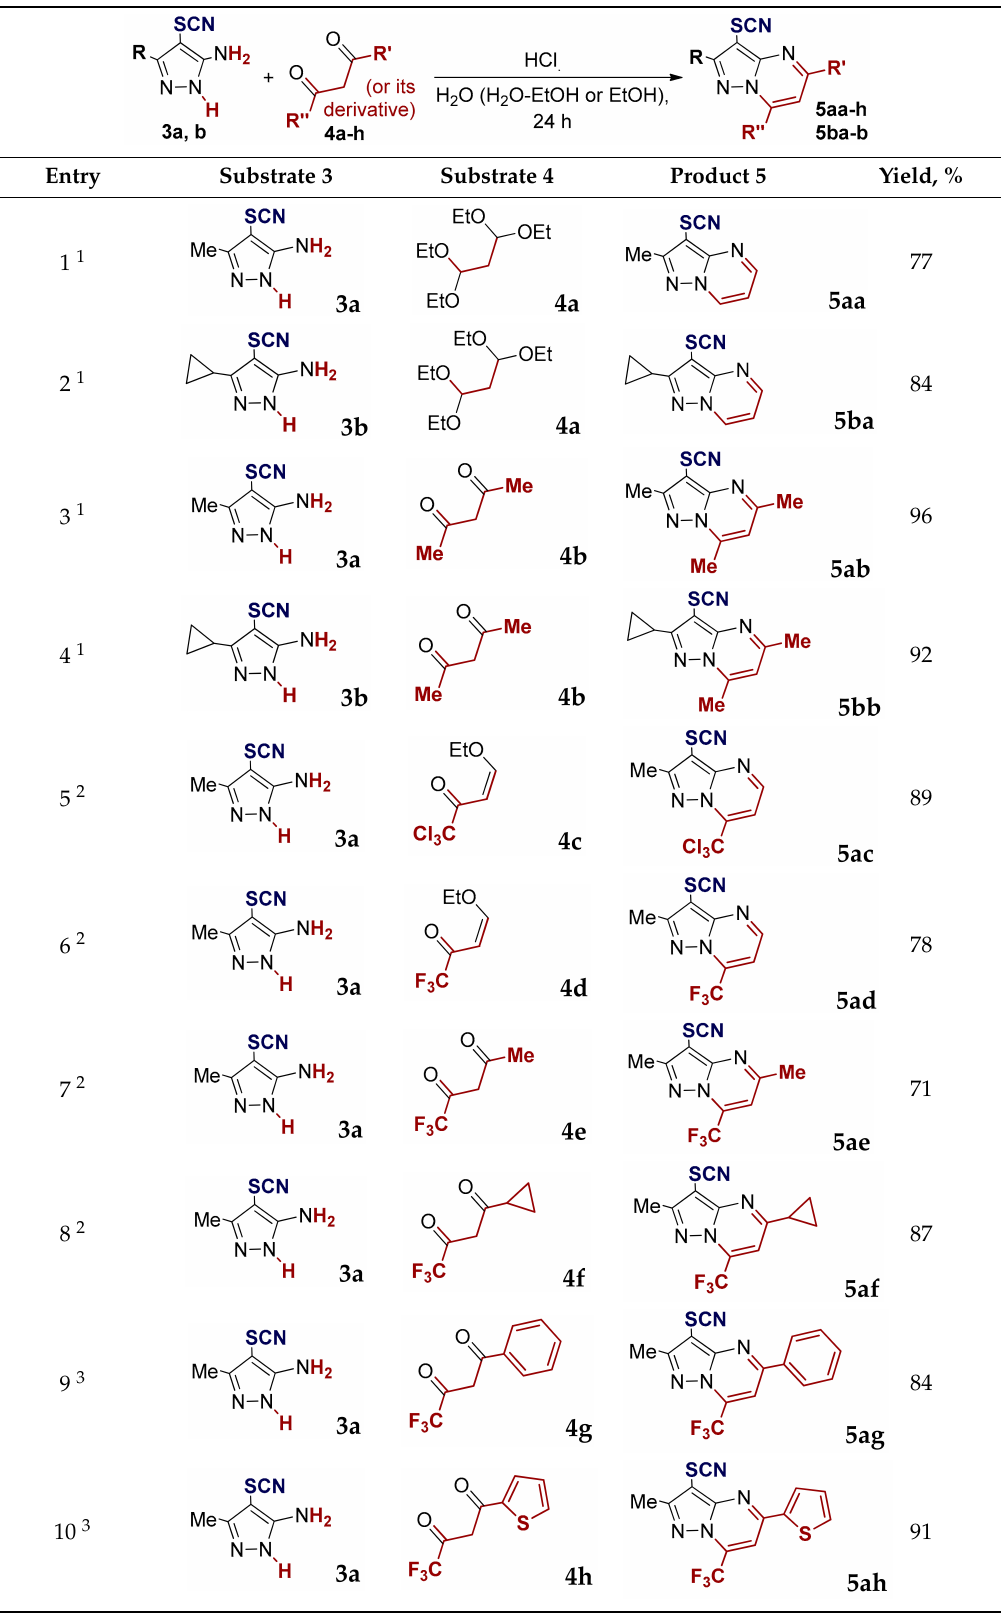
Table 4. Condensation of azoles 3a,b with 1,3-dicarbonyl compounds (or their derivatives) 4a – h